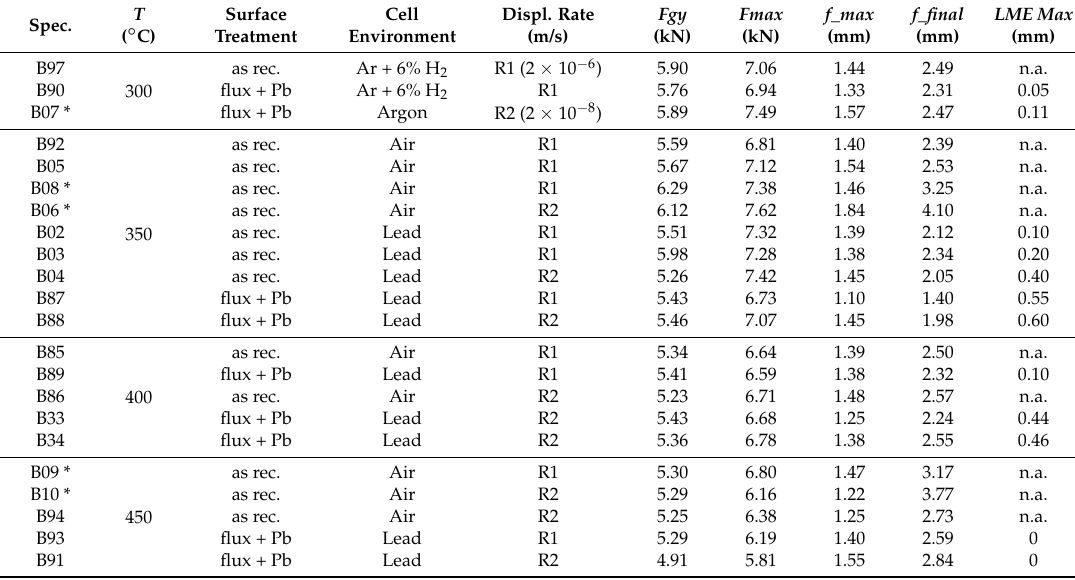
Table 5. Test results: Fgy and Fmax are loads at general yielding and maximum; f_max and f_final are displacements at maximum load and rupture. LME max is the maximum cleavage-like crack depth at rupture from SEM